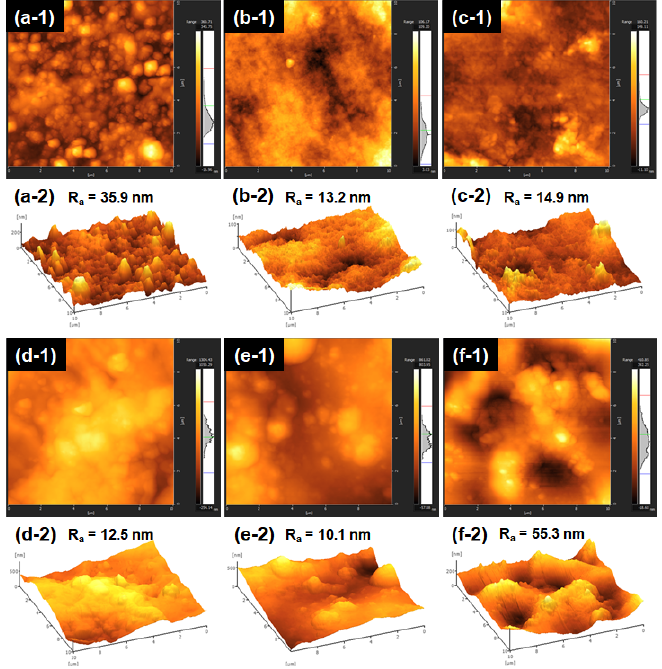
Figure 4. AFM micrographs of surfaces of GBFs with a size of 10 μ m × 10 μ m: GF ( a ); GGF ( b ); GGCF-1 ( c ); GGCF-2 ( d ); GGCF-3 ( e ); GGCF-4 ( f ).